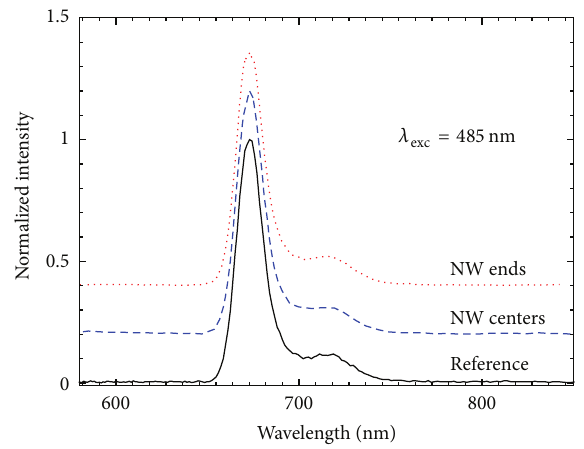
Figure 8: Fluorescence spectra of PCP complexes deposited on Ag nanowires measured for the mixed sample under excitation = 485 nm. Data obtained for the laser spot placed wavelength of 𝜆 exc at the end of the nanowire (dotted line), along the nanowire (dashed line), and off the nanowire (solid